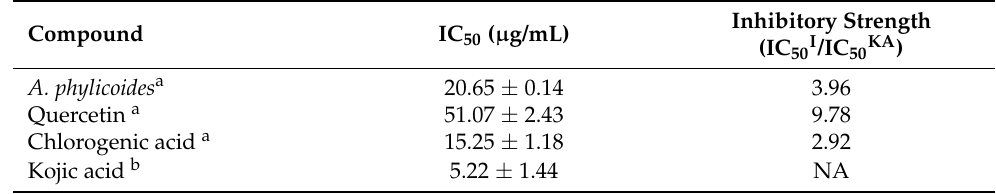
Table 2. IC 50 values for inhibition of mushroom tyrosinase by Athrixia phylicoides metabolites and kojic